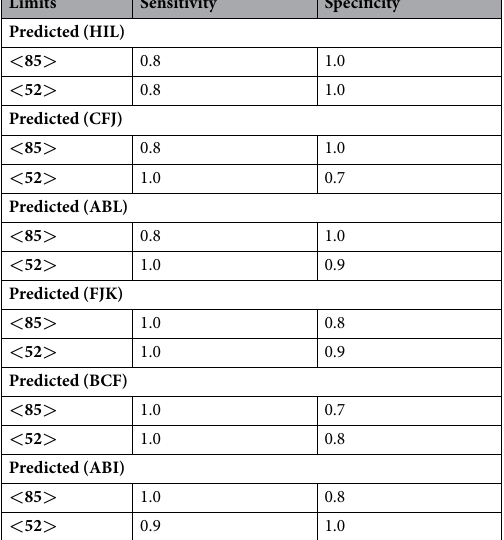
Table 2. Specificity and sensitivity tests of the QSAR models. < 85 > and < 52 > are the limits used to differentiate enzymes with high and low activity which is clearly defined in the methods section. The complete calculations can be found in Table